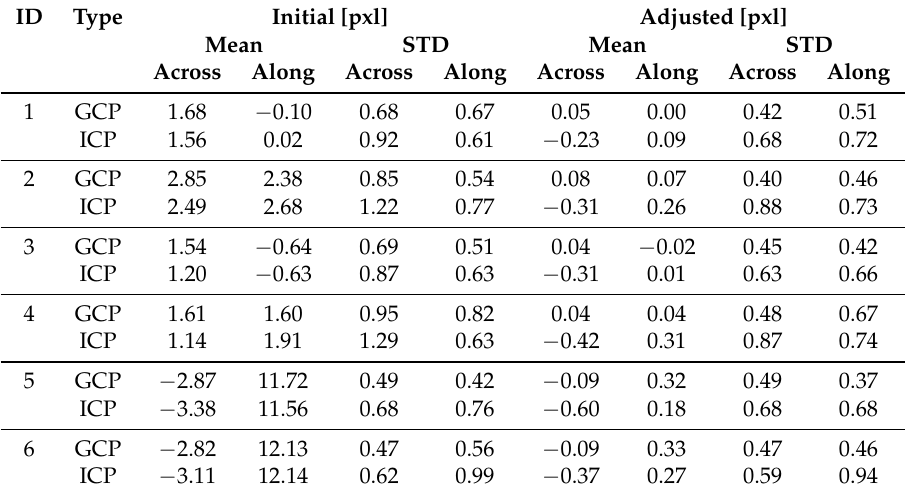
Table 5. 2D geo-location accuracy analysis for all six images of the Ljubljana test site given in pixels. For each image, the first row shows the residual errors based on GCPs and the second row the residual errors for the ICPs. After adjustment the mean STDs are 0.45 pixels for GCPs and 0.73 pixels for ICPs.